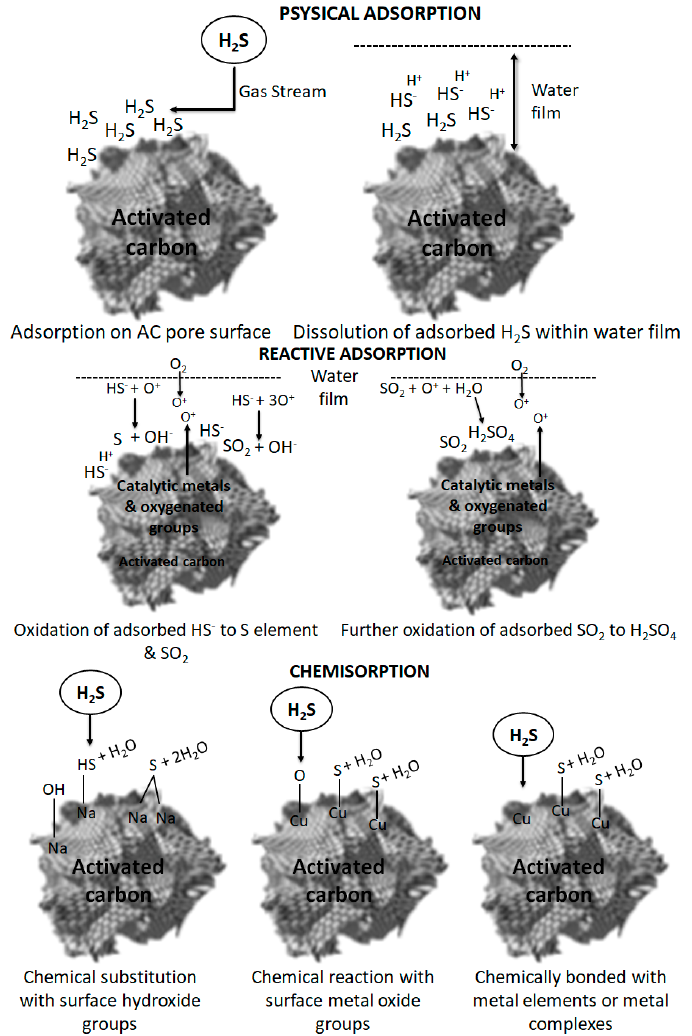
Figure 3. Physical and chemical adsorption mechanism of H 2 S onto activated carbons (adopted from [71]).